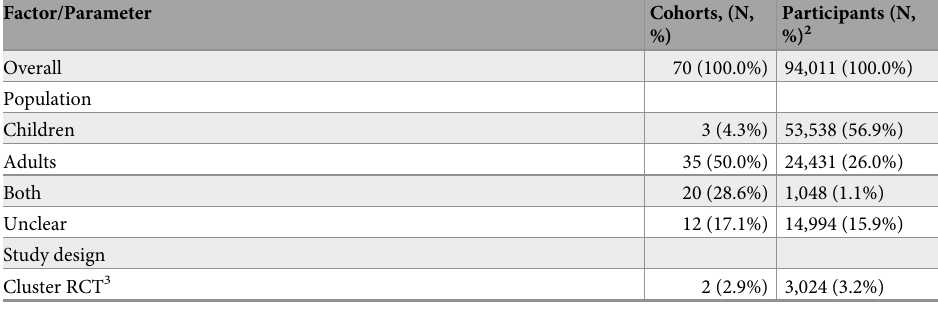
Table 1. Summary of cohorts included in the meta-analyses ( N = 70) 1